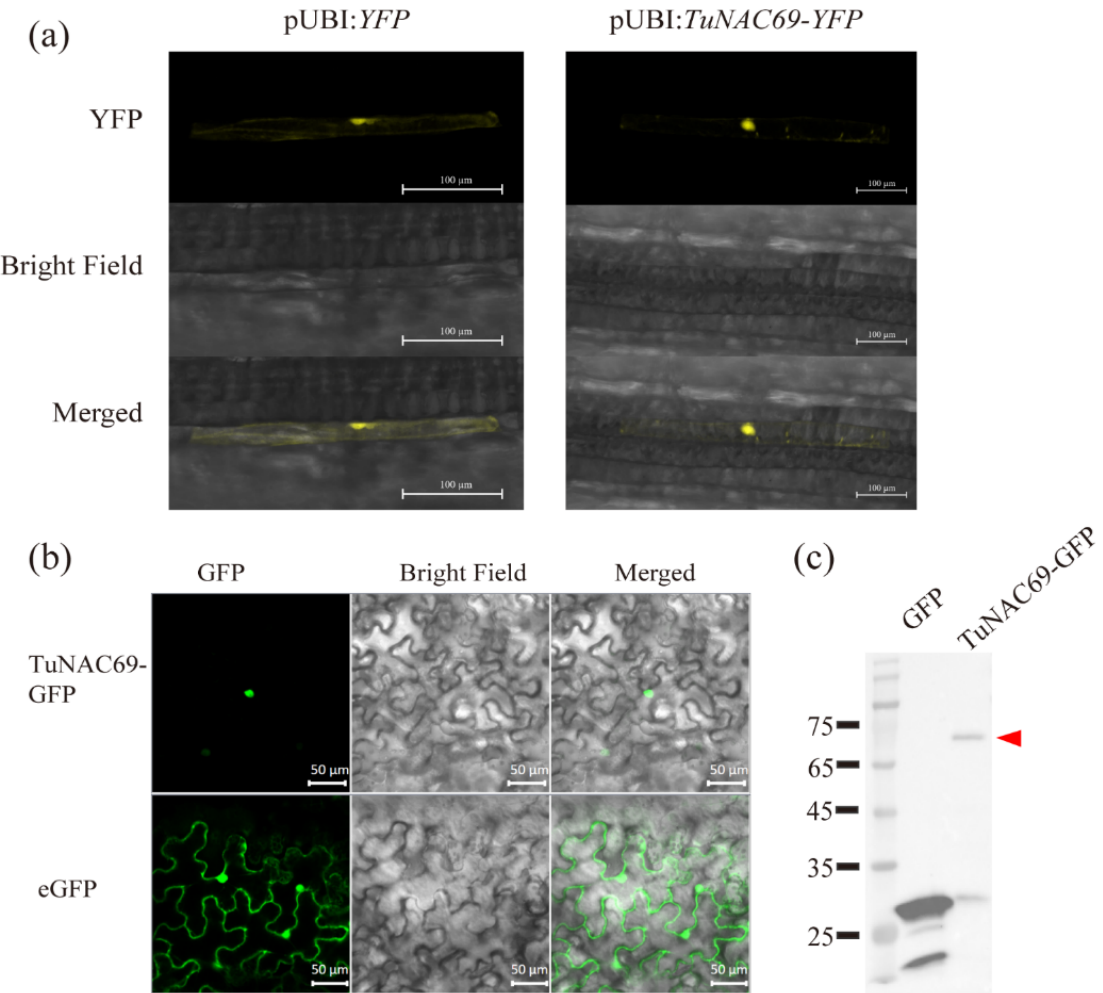
Figure 3. Subcellular localization of the TuNAC69 ‐ GFP fusion protein in wheat and tobacco. ( a ) TuNAC69 mainly localizes in the nucleus of T. aestivum cells. Bar = 100 μ m. ( b ) TuNAC69 localized in the nucleus of N. benthamiana cells. Bar = 50. ( c ) Accumulation of TuNAC69 ‐ GFP in N. bentham ‐ iana leaves by immunoblot analysis. The red triangle indicates TuNAC69 ‐ GFP.